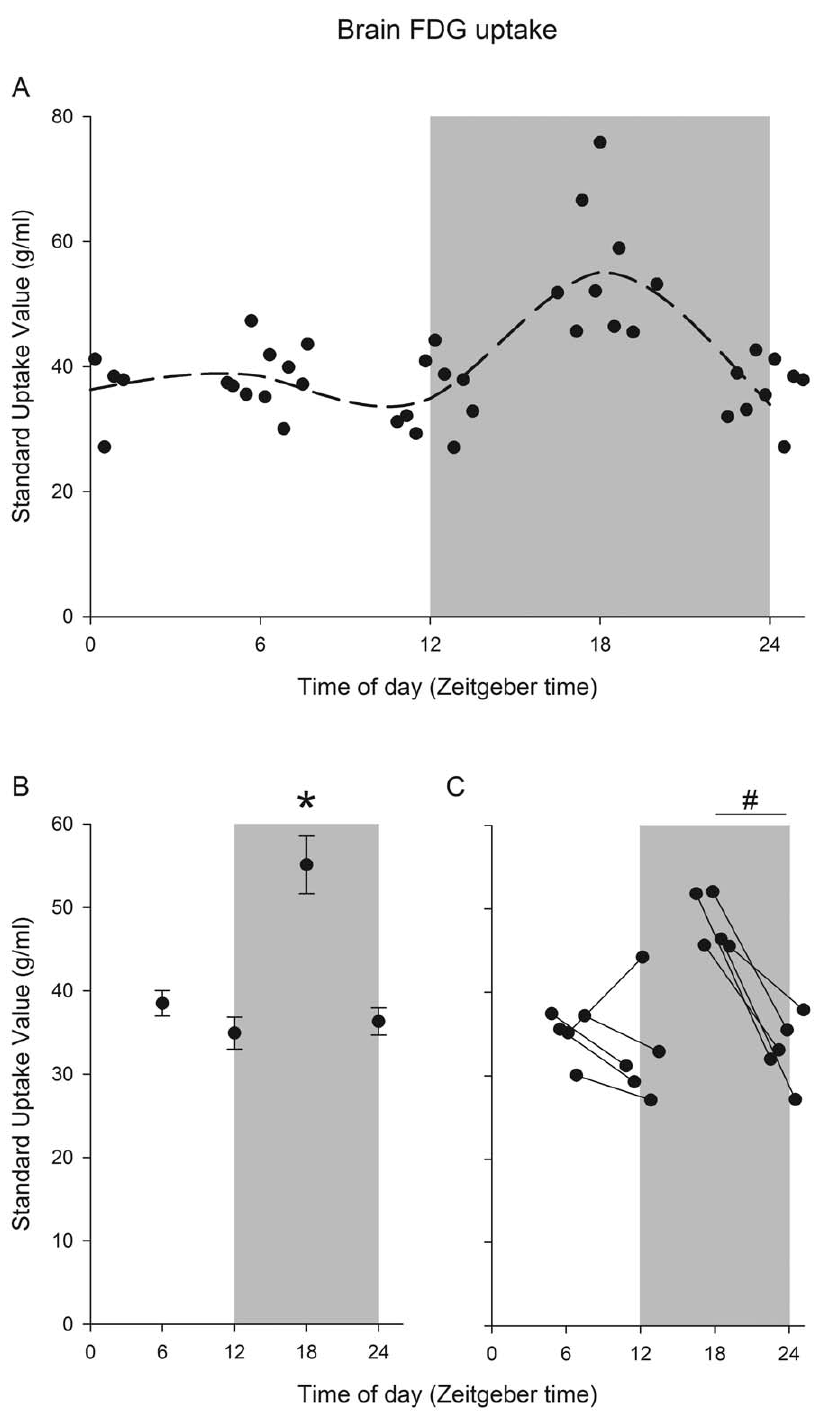
Figure 2. Time-of-day specific analysis of FDG uptake in brain. (A) Whole Brain FDG uptake in C57Bl/6 mice (N=37) plotted at the time of measurement. The dashed line is a smoothed spline curve through group averages. Both group averages (B) and within individual comparisons at different times of day (C) of total brain FDG uptake showed significantly higher uptake at the middle of the active phase at ZT 18. Error bars indicate SEM. *=Proc mixed, least square means contrast: P , 0.005, P , 0.001 and P , 0.001 with ZT 6, ZT 12 and ZT 24/0. # =Paired t-test P , 0.005. doi:10.1371/journal.pone.0031792.g002 and may indicate that even minor aspects of the overall profile are Differences are noted in the amplitudes of the 24-hour variation still consistent. Animals were awake during FDG uptake and alive in FDG uptake in different brain regions. The SCN of the during PET scanning, and an unanaesthetized state has been hypothalamus, containing the major circadian oscillator, is the shown to increase brain FDG uptake [25]. only brain region reported in nocturnal rodents to show elevated